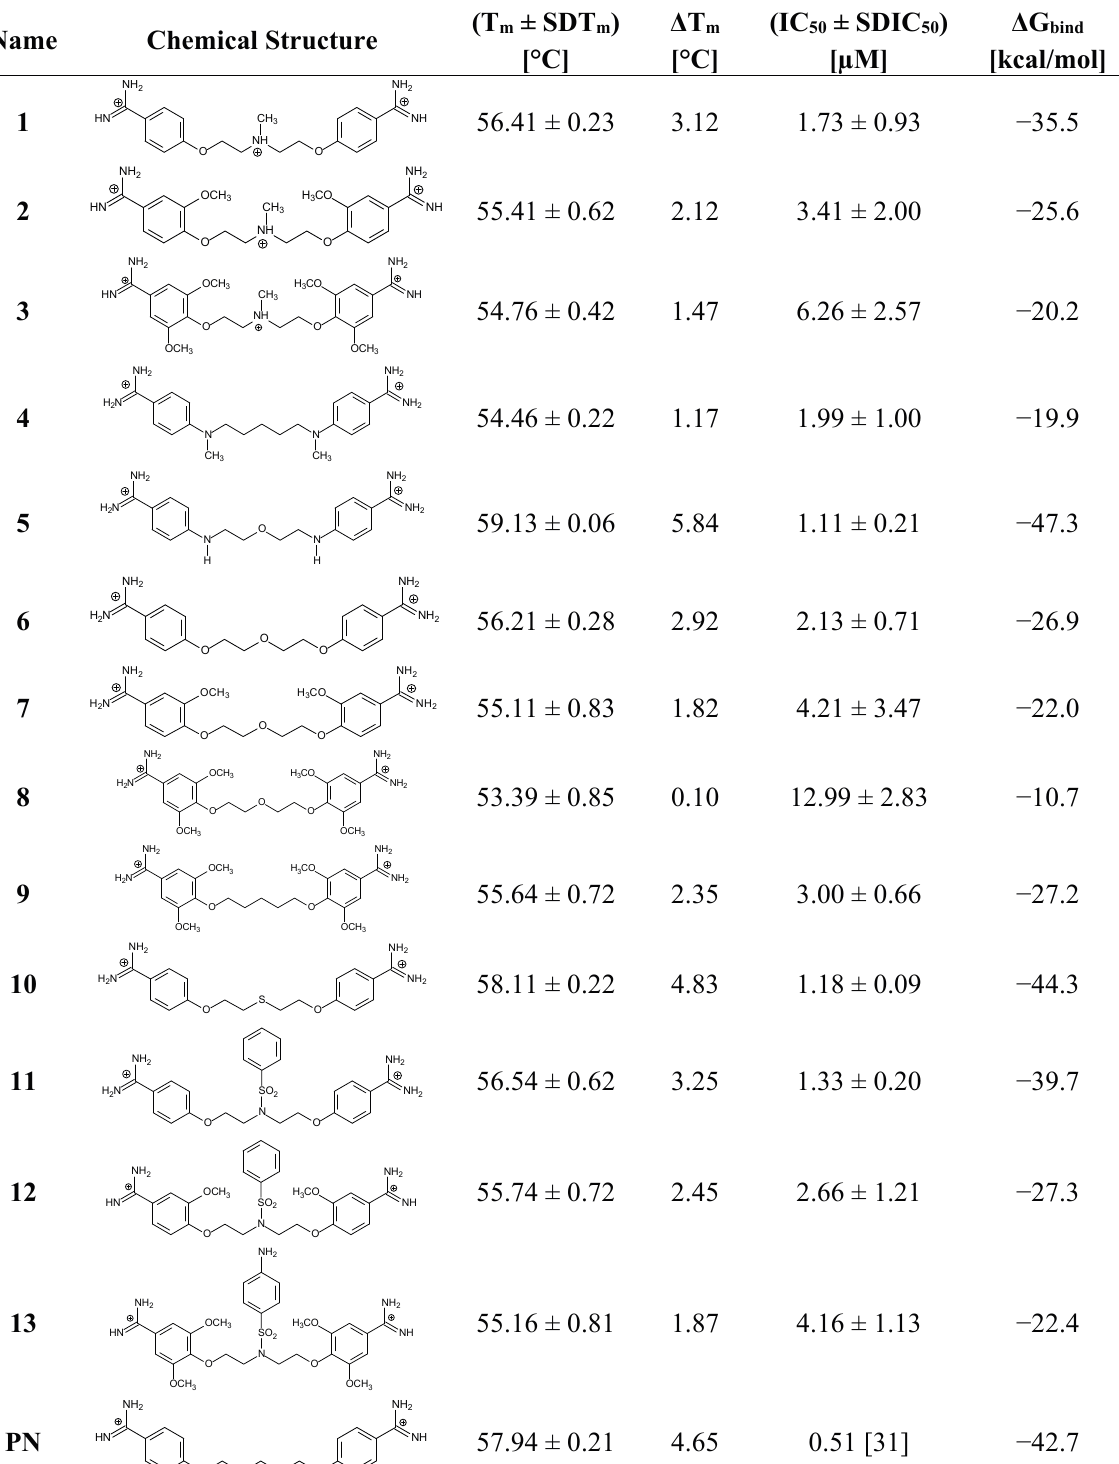
Table 1. The structures of pentamidine analogs 1 – 13 , an increase of melting temperature of the 5'-(CGCGAATTCGCG) 2 -3' dodecamer complex after complexation ( Δ T m ), anti- Pnemocystis carinii activities (IC 50 ), and free energies of binding ( Δ G bind ) of DNA-ligand using MM-PBSA